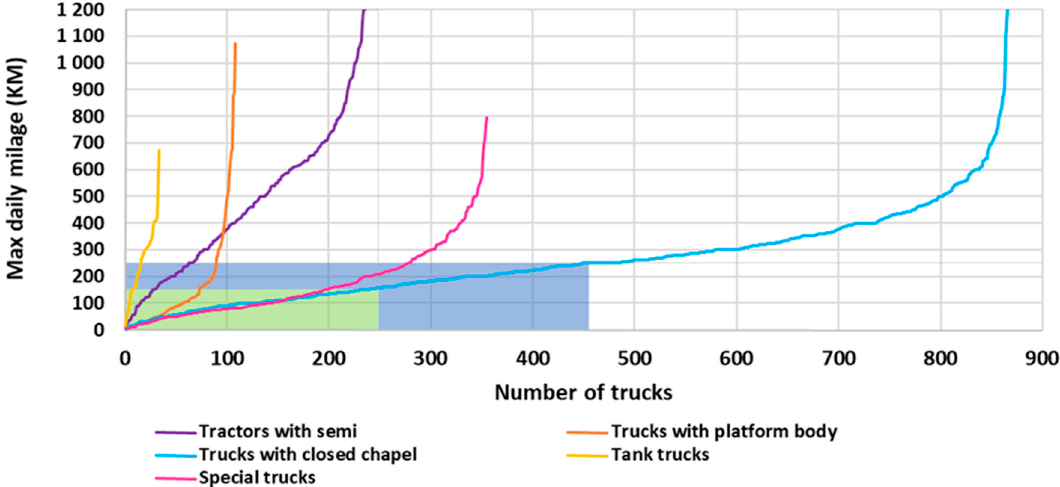
Figure 2. Maximum daily mileage (km) for individual trucks in di ff erent truck categories in the sample of Statistic Norway’s truck survey. For trucks up to five years old, with engines up to 500 HP, and without trailer, except for tractors with semitrailer. Green area: potential for electrification; all-electric driving range, no daytime charging, blue area: electrification can under some circumstances be possible with current battery electric truck status. Source: Base data of Statistics Norway’s ‘survey of trucks’ for 2016 and 2017 and NPRA’s Autosys